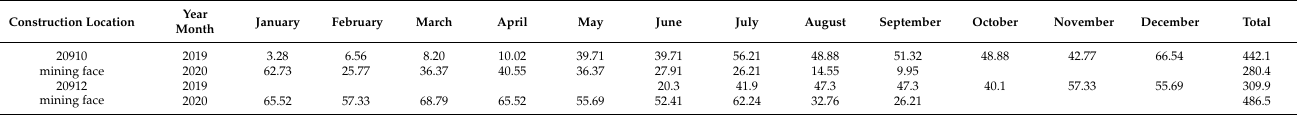
Table 3. Gas drainage